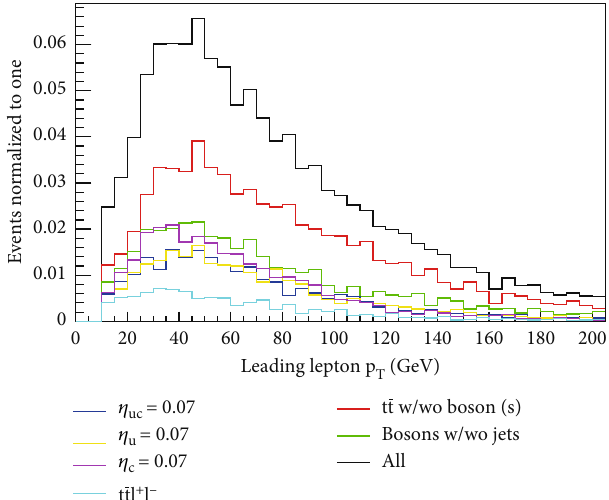
Figure 7: p distribution of signal and background processes for T leading